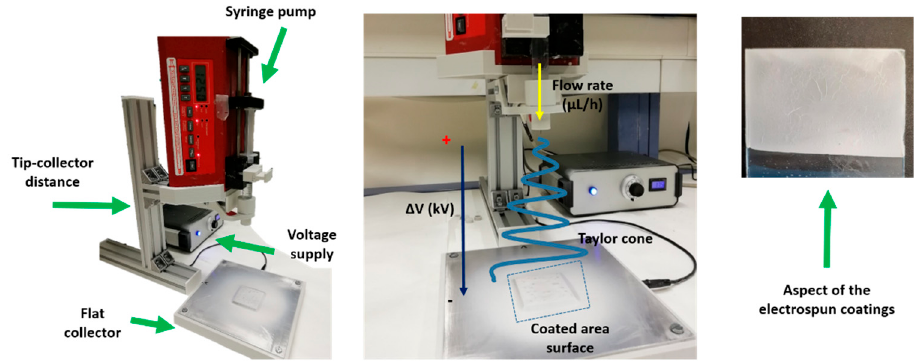
Figure 1. Experimental setup used for the fabrication of the electrospun fibers as a function of the control of tip–collector distance, applied voltage and flow rate, showing the aspect of the electrospun fibers.